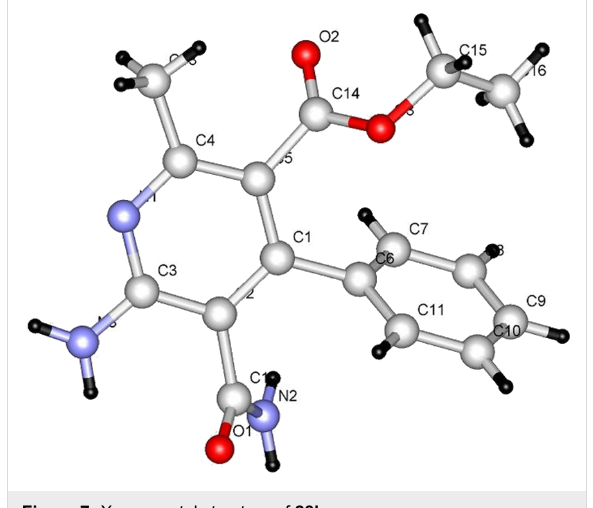
Figure 7: X-ray crystal structure of 28b